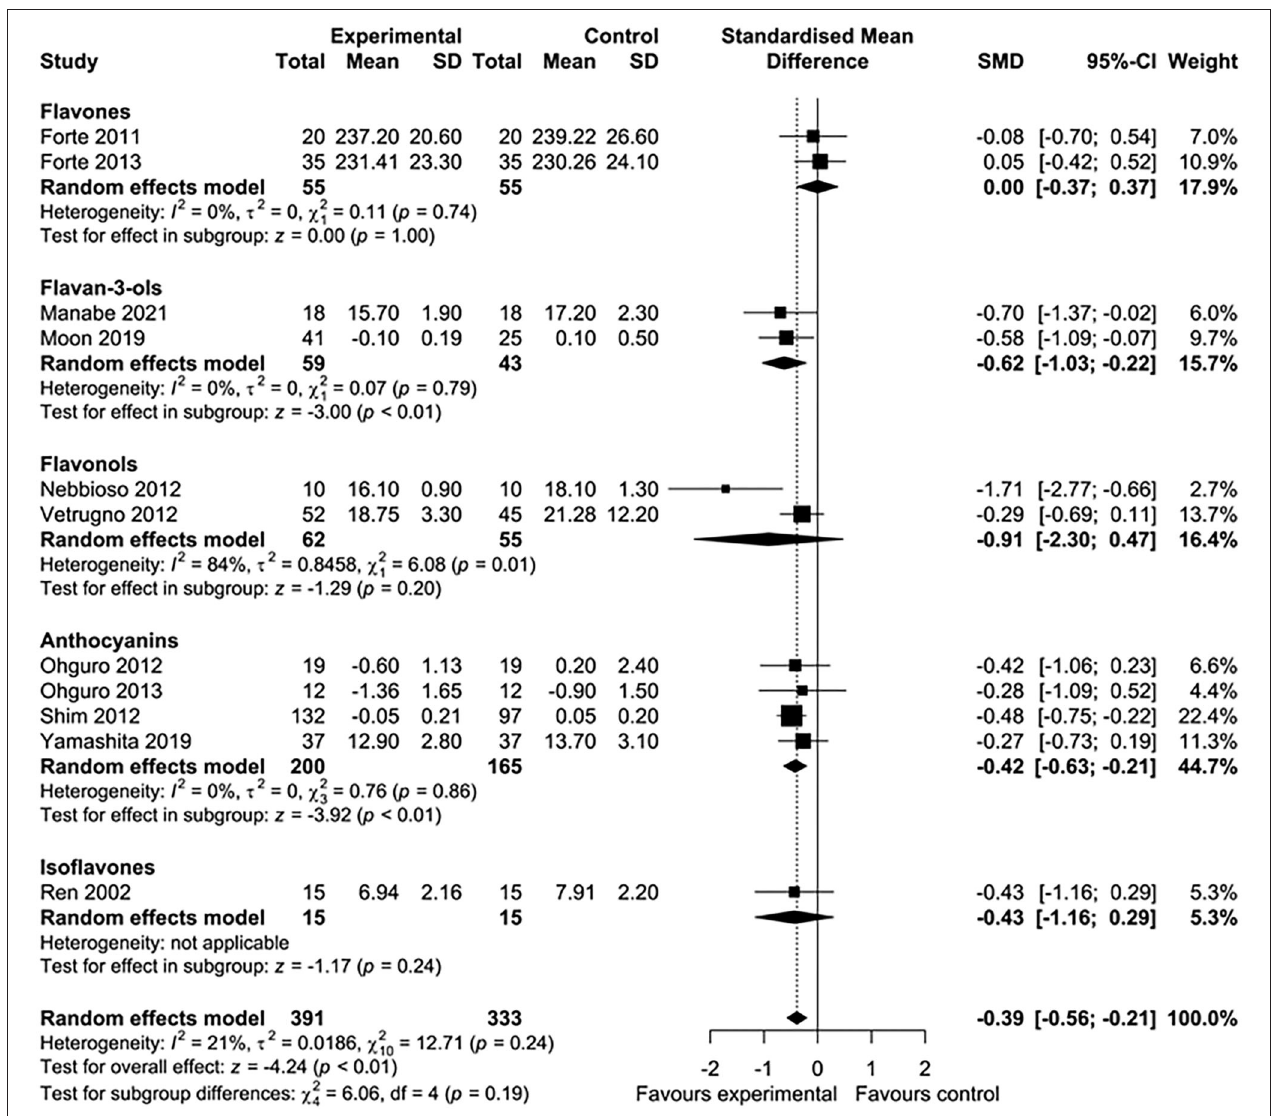
FIGURE 4 | Subgroup analysis to assess the effect of flavonoid subclasses on ocular